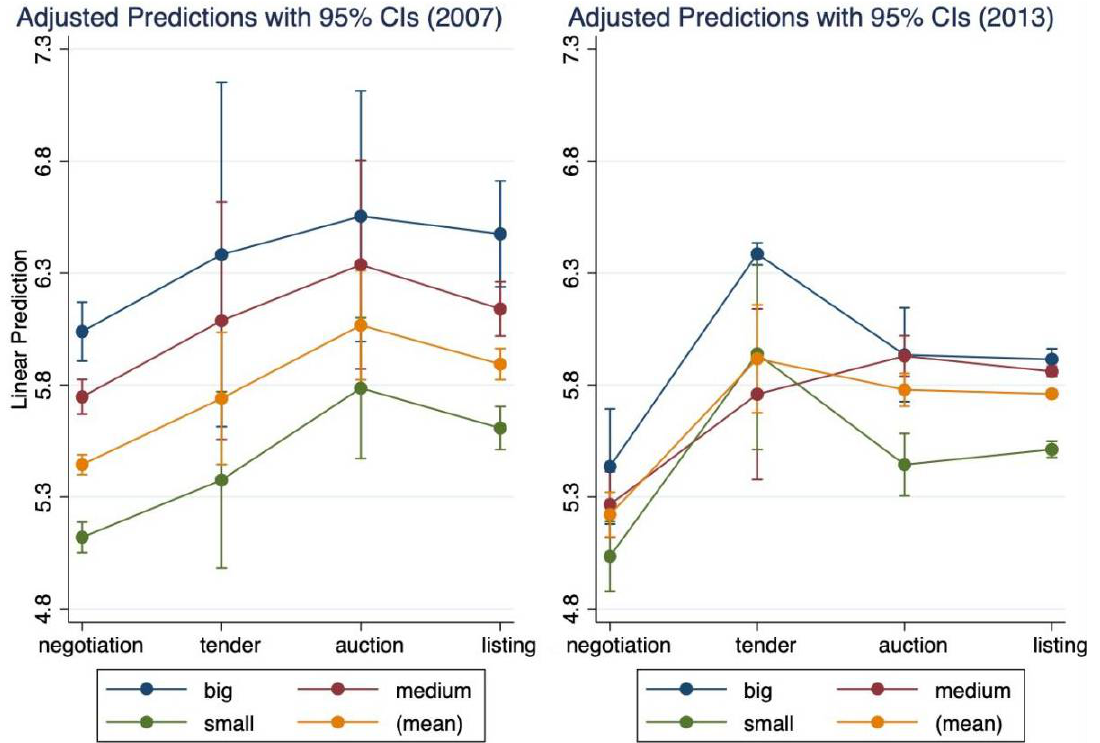
Figure 4. Average marginal effect of cross-products of enterprise scales and transfer modes on land purchase prices in 2007 and 2013.